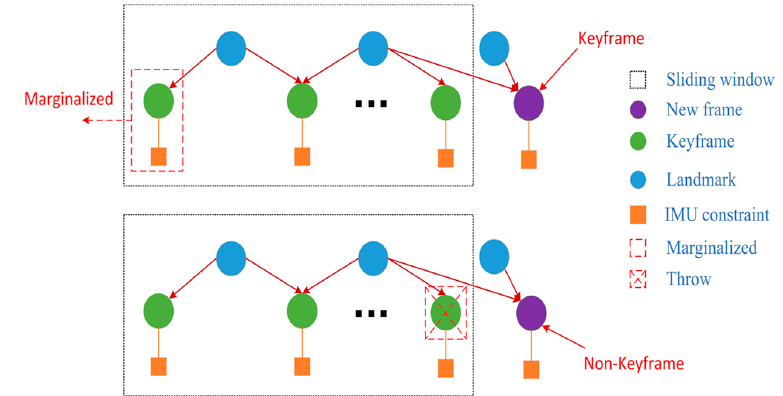
Figure 6. Marginalization strategy of our system.